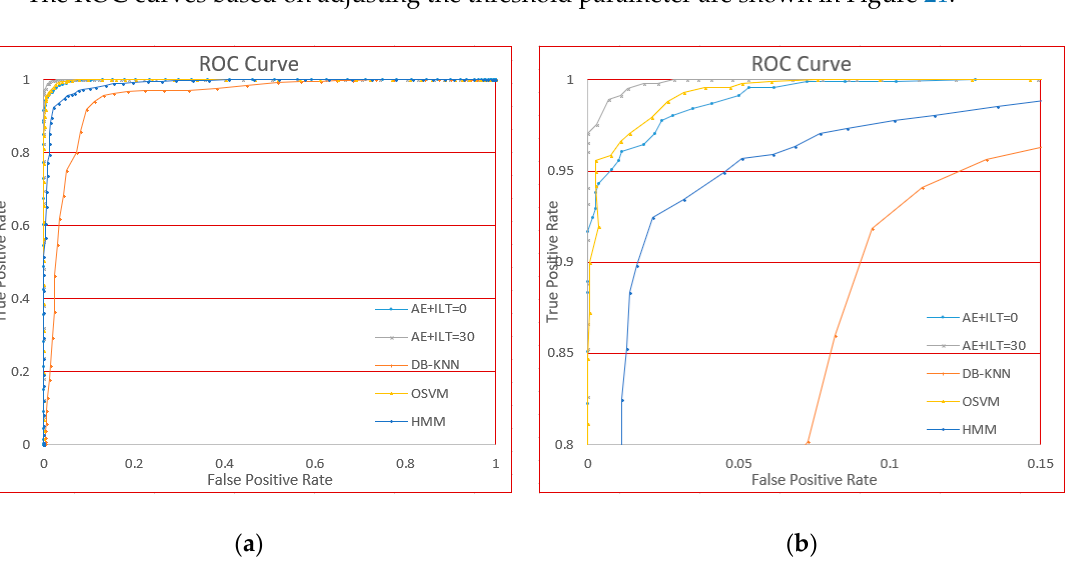
Figure 21. The ROC curves for different methods. ( a ) Is the global curve and ( b ) is the local curve for clarity.